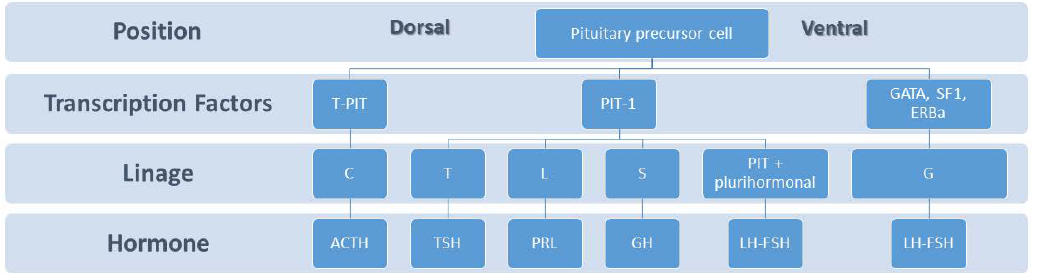
Figure 1. The dorsal and ventral side of the embryonic pituitary generate proliferative and positional signals which regulate the expression of transcription factors. The T-PIT signal differentiates the most dorsal cells into corticotropes (C). Pit1 is induced in the caudomedial region of the pituitary gland, which ultimately gives rise to somatotropes (S), lactotropes (L), and thyrotropes (T). On the ventral side when GATA, SF1, ERBa are activated, the gonadotrope lineage (G) is determined.